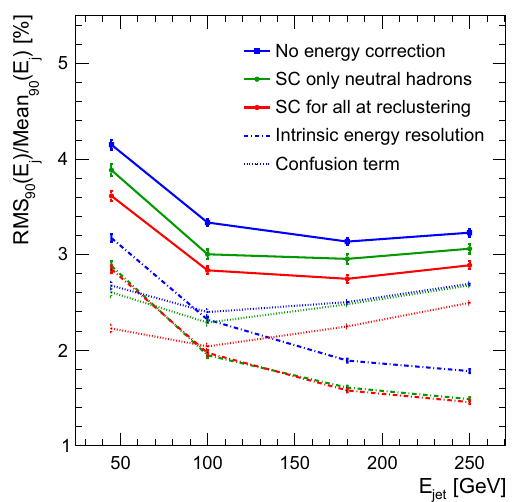
Fig. 8 JetenergyresolutionfortheILDdetectorwith3 × 3 cm 2 HCAL cell size without energy correction (blue), when applying SC for neutral clusters at PFO level (green) and when applying SC at the reclustering step for all clusters (red). The long-dashed lines present the intrinsic energy resolution, the dotted lines present the confusion